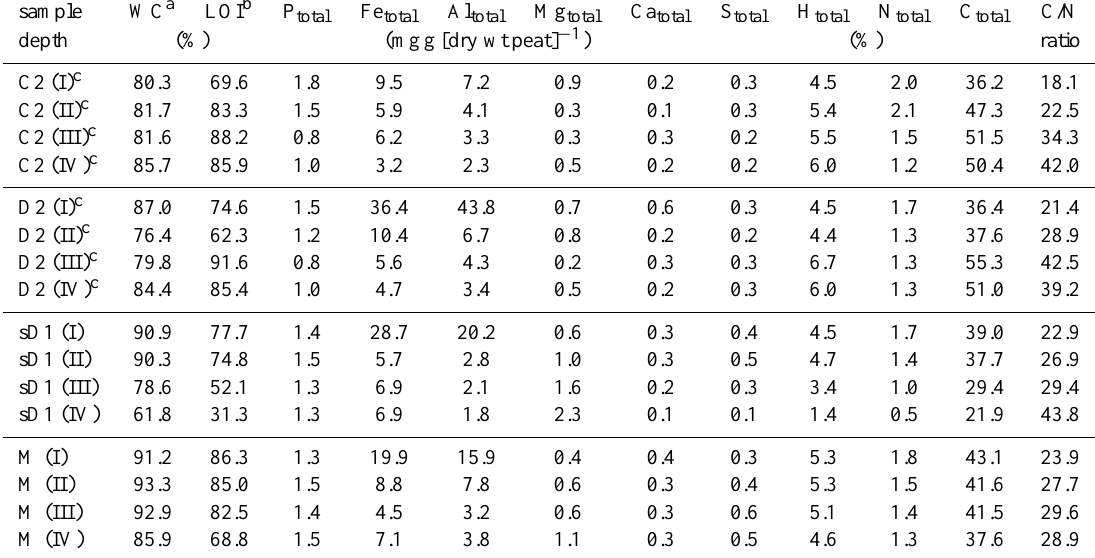
Table 2. Chemical characteristics of peat obtained from an acidic fen (pH 4.7) along a hydrological gradient (from the middle to the south C2 → D2 → sD1 → M) over 4 depths (I: 0–10cm, II: 10–20cm, III: 20–30cm, and IV: 30–40cm) in November 2006.